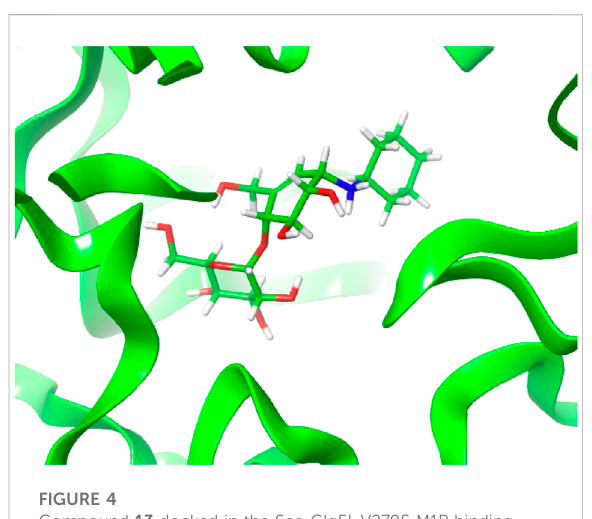
FIGURE 4 Compound 13 docked in the Sco GlgEI-V279S M1P binding site.